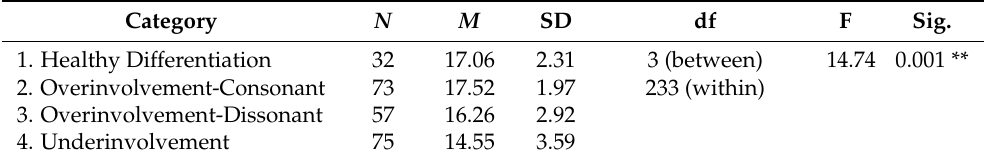
Table 5. Descriptives: Family History Knowledge and Stutman and Lich’s (1984) Differentiation